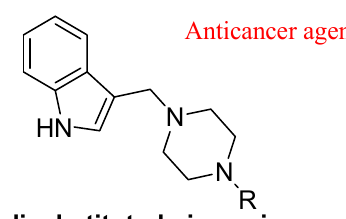
Figure 29. 3-[(4-Substituted-piperazin-1-yl)methyl]-1 H -indole derivatives.